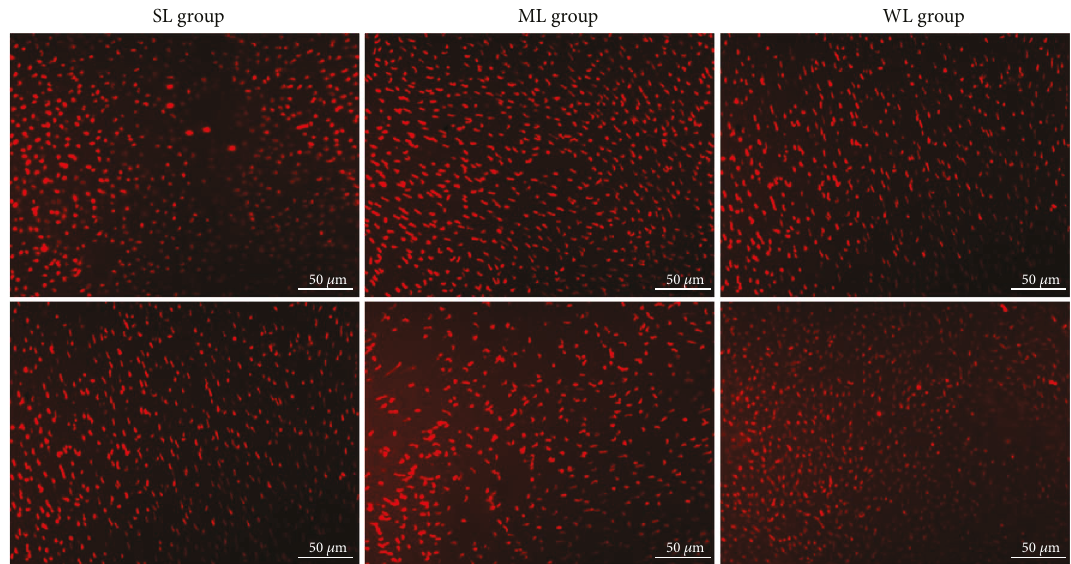
Figure 3: M-cones changed in di ff erent areas in the three groups. Top: dorsal retina; bottom: ventral retina. SL: short-wavelength light; ML: middle-wavelength light; WL: white light. Scale bar =50 μ m. Table 1: The densities of S-cones and M-cones in the di ff erent groups (mean ± SD, mm 2 ).